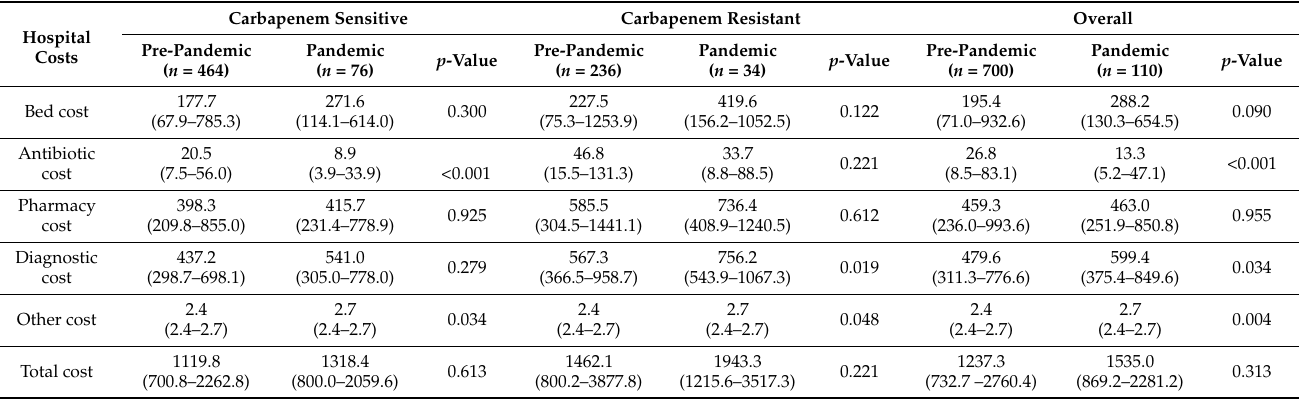
Table 6. Comparison of various costs by Carbapenem-resistance, susceptible, and duration of